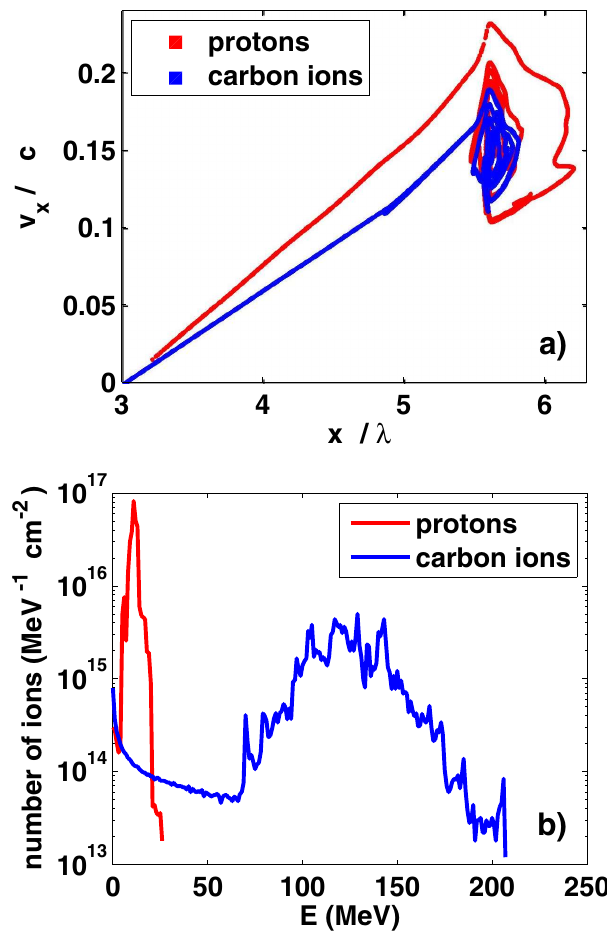
FIG. 6. (Color) Ion phase space (a) and ion energy distributions (b) at the end of the interaction of the laser pulse with a foil composed of fully ionized carbon ions and protons. The density of carbon ions is 7 : 5 (cid:2) 10 21 cm (cid:4) 3 and the density of protons is 2 times higher. The other simulation parameters are the same as in Fig. 3 (the mass density of the foil is the same as